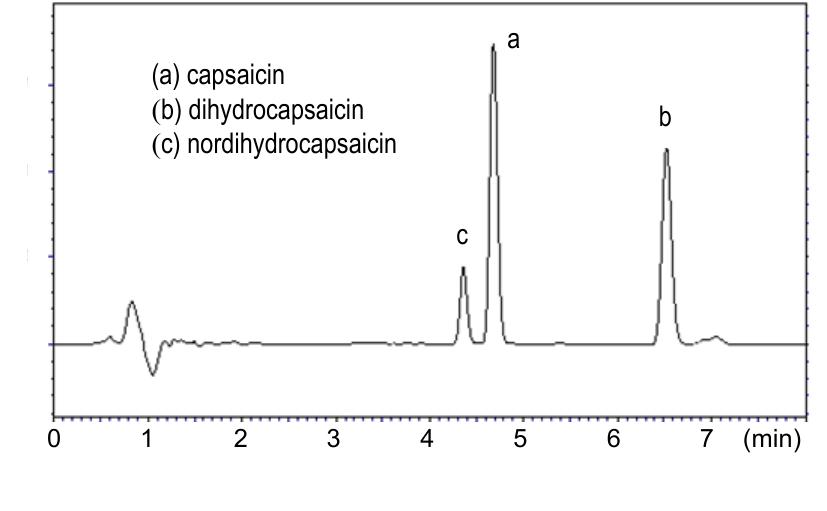
(150 × 4.6 mm × 3 μ m), 18